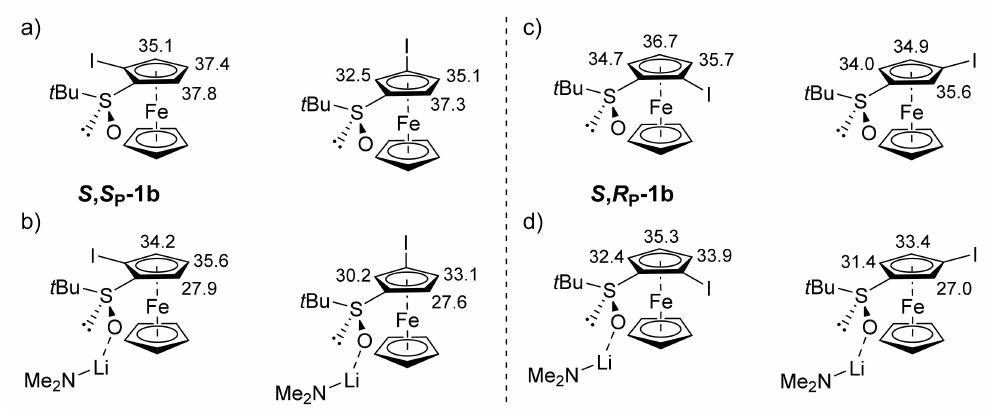
Figure 3. Selected calculated p K a values of the ( a , c ) 2- and 3-iodinated S - tert -butylferrocenesulfoxides, and ( b , d ) their complexes with LiNMe 2